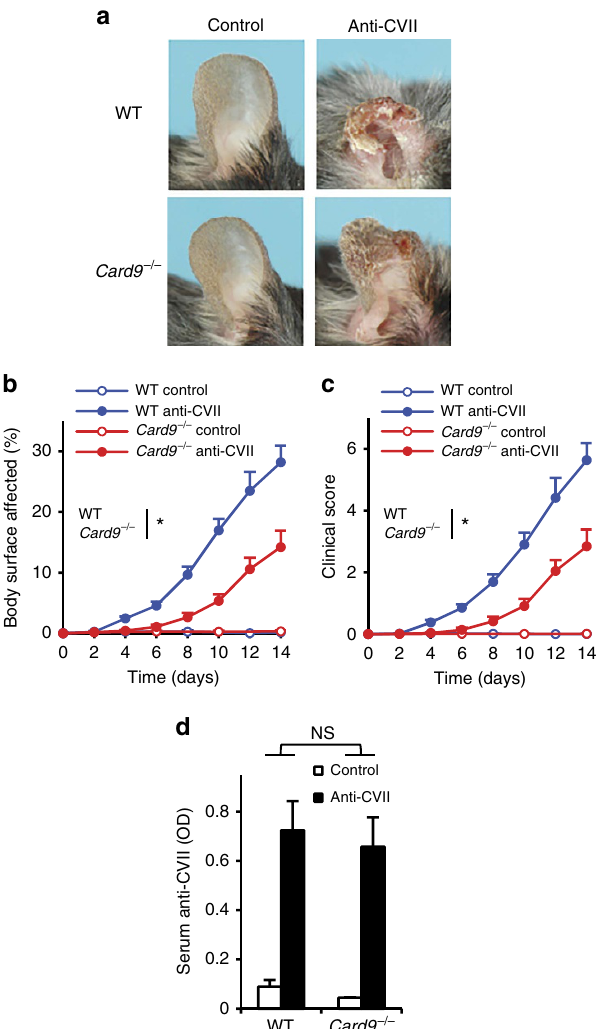
Figure 2 | CARD9 in autoantibody-induced skin blistering disease. Blistering skin disease was triggered in wild type (WT) and Card9 (cid:2) / (cid:2) intact mice or bone marrow chimeras by systemic injection of collagen VII- specific (anti-CVII) antibodies. Skin disease was followed by photographing on day 14 ( a ) and clinical assessment of the total body surface affected ( b ) and the overall disease severity ( c ). The serum titre of anti-CVII antibodies was tested on day 6 by ELISA ( d ). Representative images ( a ) or mean and s.e.m. ( b – c ) from 7 to 9 control (2 intact and 5–7 bone marrow chimeric) and 13–14 anti-CVII-treated (2 intact and 11–12 bone marrow chimeric) mice per genotype from four independent experiments are shown. No difference between intact and chimeric mice of the same hematopoietic genotype was observed (not shown). ( d ) Mean and s.e.m. from 4 control and 12–13 anti-CVII-treated mice from five independent experiments are shown. * P o 0.05; NS, statistically not significant (two-way ANOVA); see the text for actual P